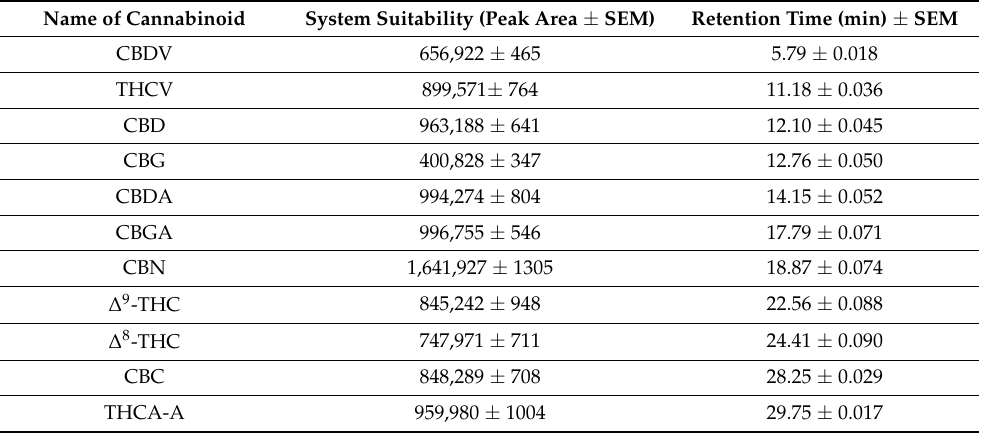
Table 3. Precision and accuracy of 11 cannabinoids on intra-day and inter-day.